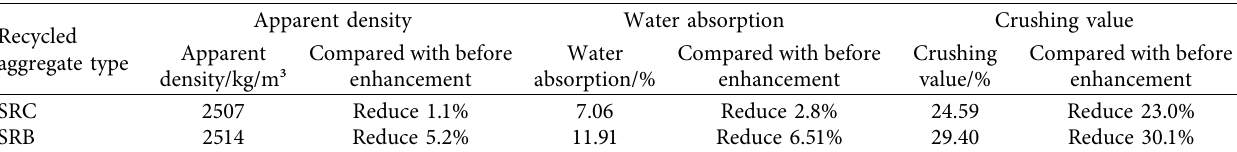
Table 1: Physical and mechanical indexes of two recycled aggregates before and after strengthening. Recycled